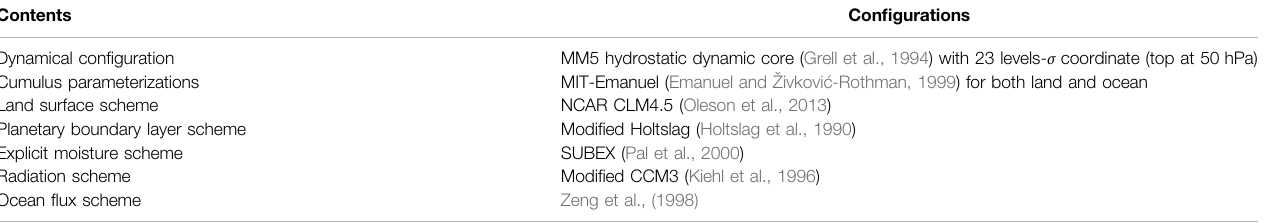
TABLE 1 | The con fi gurations of the model and the selections of the parameterization schemes.